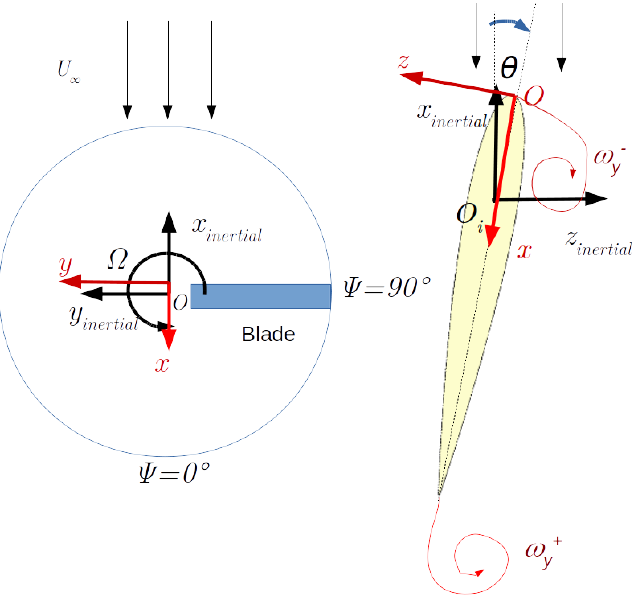
Figure 3. Illustration of coordinate systems used in analysis: the Inertial coordinate, of which the origin is positioned at blade rotation/pitch center, and the body-fixed coordinate, of which the origin is at blade leading edge. All of the aerodynamic variables are defined according to the body-fixed coordinate.